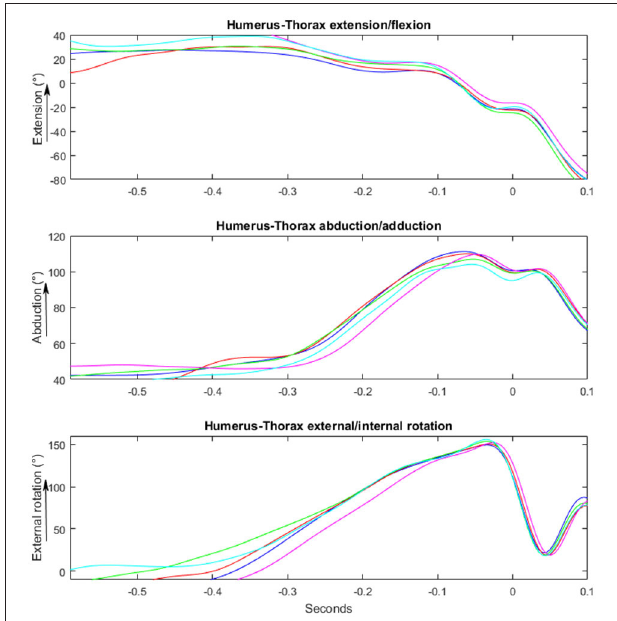
FIGURE 5 | Illustrating a kinematic movement of a standing overhead throw performed by a player playing with pain. Y-axis shows the changes in degrees/ ◦ . X-axis shows the time in milliseconds, where 0 is the time of